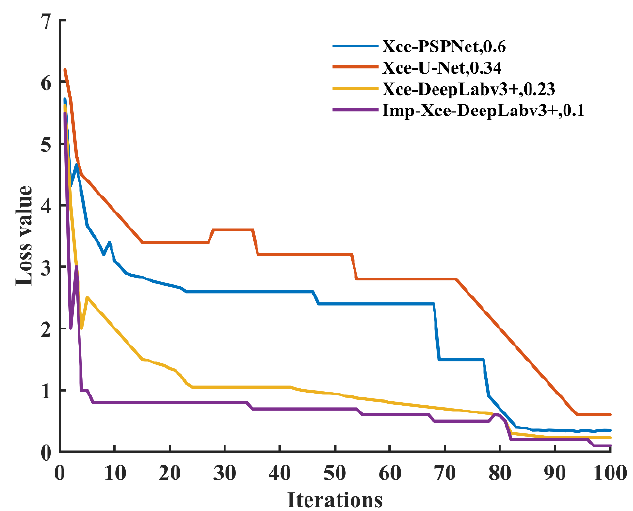
Figure 6. Loss curves of four different models.